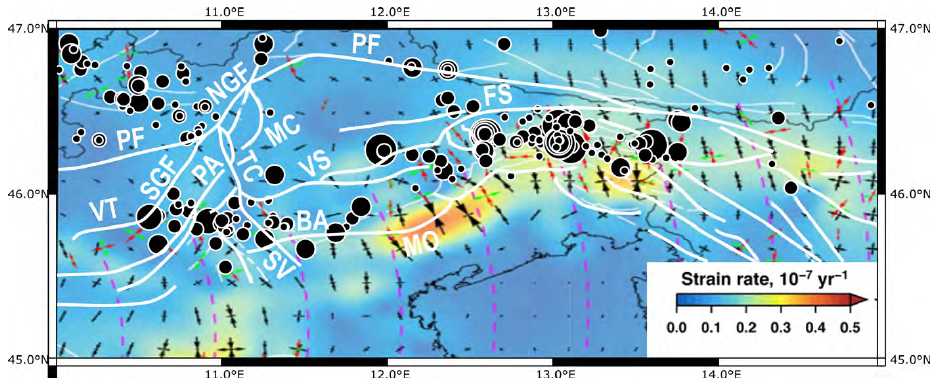
Figure 13. Epicentres of seismic events from 2017–2018 ( M L ≥ 1; the size of the black dots indicates earthquake magnitudes up to M L 4.2) compiled from the SWATH-D Network (Jozi Najafabadi et al., 2021) superposed on strain rates determined from GPS velocities (following Serpelloni et al., 2016). Note that the area in the centre with the highest strain rates (vicinity of the Montello Thrust) coincides with lower seismic activity, although clustering of low-magnitude events has been reported (Moratto et al., 2019; Romano et al., 2019). FS stands for Fella-Sava Fault; see Fig. 1 for the other fault